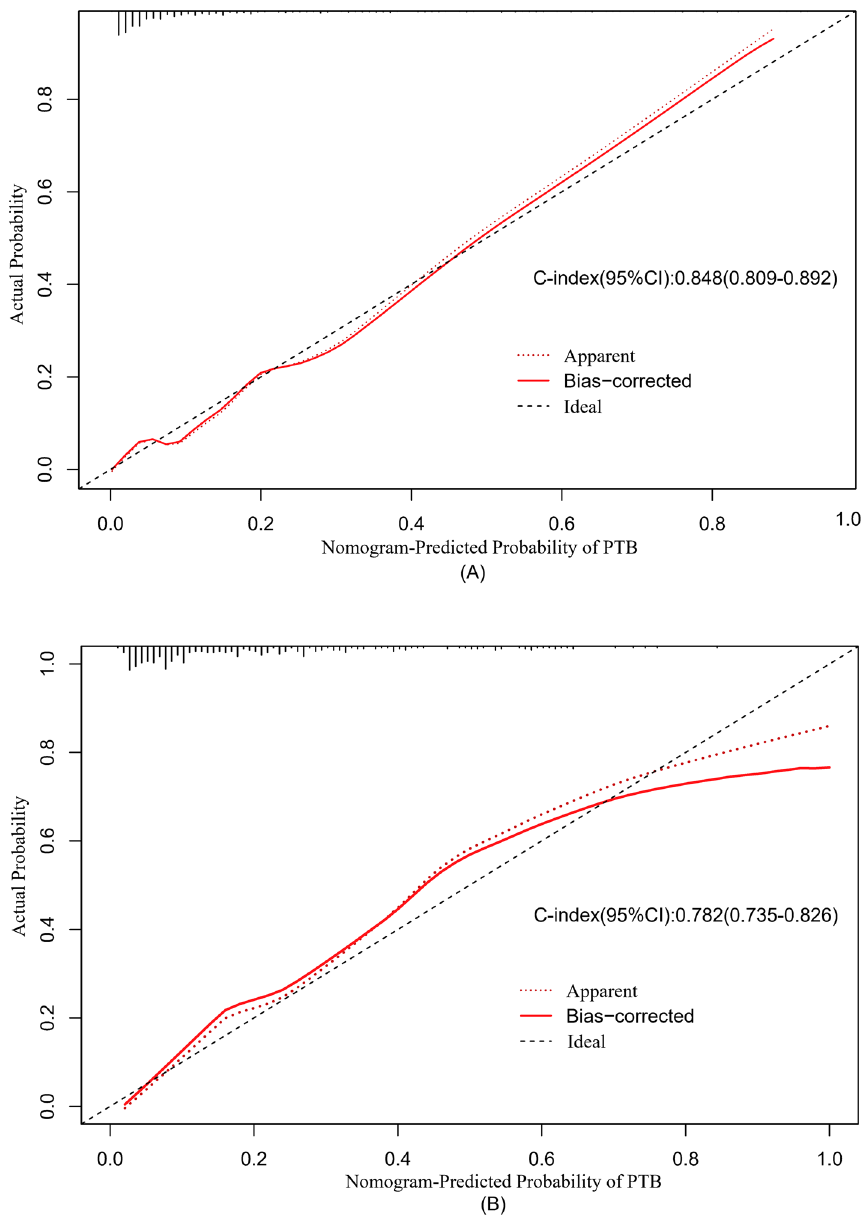
Figure 5. Calibration plots for the predicted and observed overall risk of the nomograms in ( A ) the training group; ( B ) the external validation group. The x-axis demonstrates the nomogram-predicted probability, and the y-axis shows the actual observed